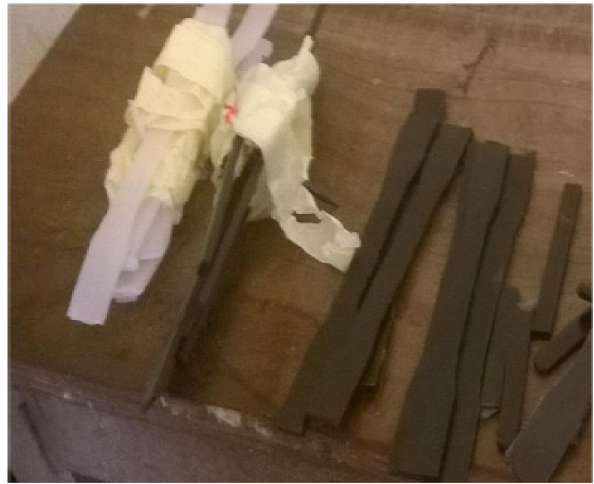
Figure 35. PLA–GSP nanocomposite samples [135].